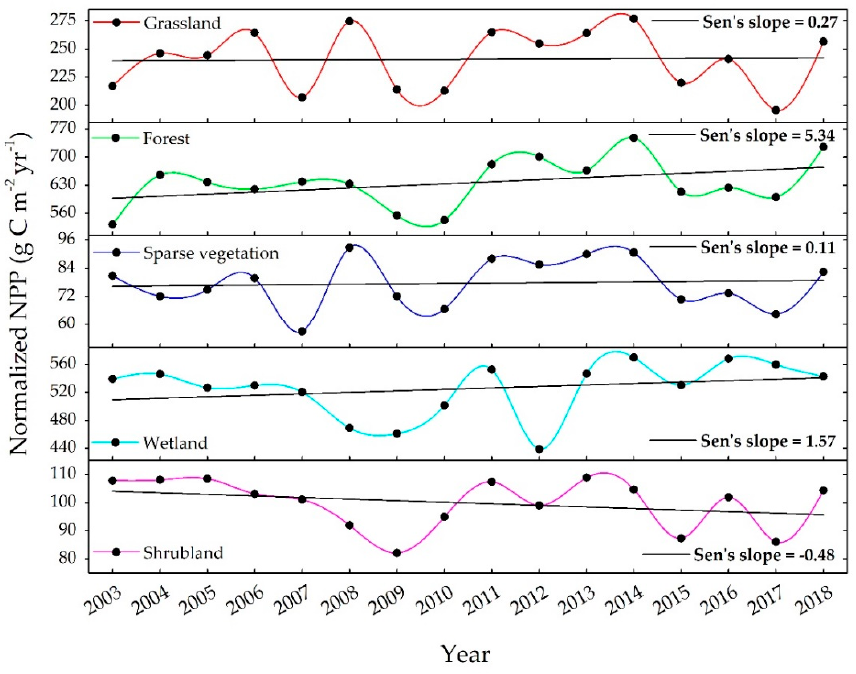
Figure 6. The annual NPP per unit area of different vegetation types from 2003 to 2018. Normalized NPP by land cover areas showed increment by 0.27, 5.34, 1.57, and 0.11 g C m − 2 y − 1 in grassland, forest, wetland, and sparse vegetation, respectively; while NPP in shrubland vegetation decreased by ‐ 0.48 g C m − 2 y − 1 (Figure 6). However these NPP trends were not statistically significant, and the NPP fluctuated due to the changes in cli ‐ matic parameters. For example, grassland and sparse vegetation NPP were lower during the dry years (2007/2009/2010/2017), reflecting these two vegetation types are more sensi ‐ tive to climatic parameters. All vegetation types show depressed NPP in 2009 and 2010, which mainly correspond with less precipitation and higher temperature, while net radi ‐ ation was average. In contrast, high NPP values were observed in 2014 for all vegetation types, which was also the wettest year of the study period. 3.2.2. Seasonal NPP Variations by Vegetation Types Furthermore, the statistical analysis was performed to understand seasonal variation in two contrasting (dry and wet) years for the five land cover types because seasonality is a dominant characteristic of most ecosystems. There was an apparent seasonal vegetation NPP pattern depicted in Figure 7: low and stable from October to April of each year, and high in summer, which coincided with the growing season from May to September. A large variation in the growing season NPP was found between dry and wet years, partic ‐ ularly in grassland, sparse vegetation and shrubland. This further verifies that these veg ‐ etation types are susceptible to climatic parameters than others. On the other hand, the wetland has less NPP difference among dry and wet years followed by forest, which can be attributed to soil and vegetation water content. Among other vegetation types, sparse vegetation was not following the general NPP trend of the growing season in the dry year, while it soared when NPP in other land cover types started declining (Figure 7).